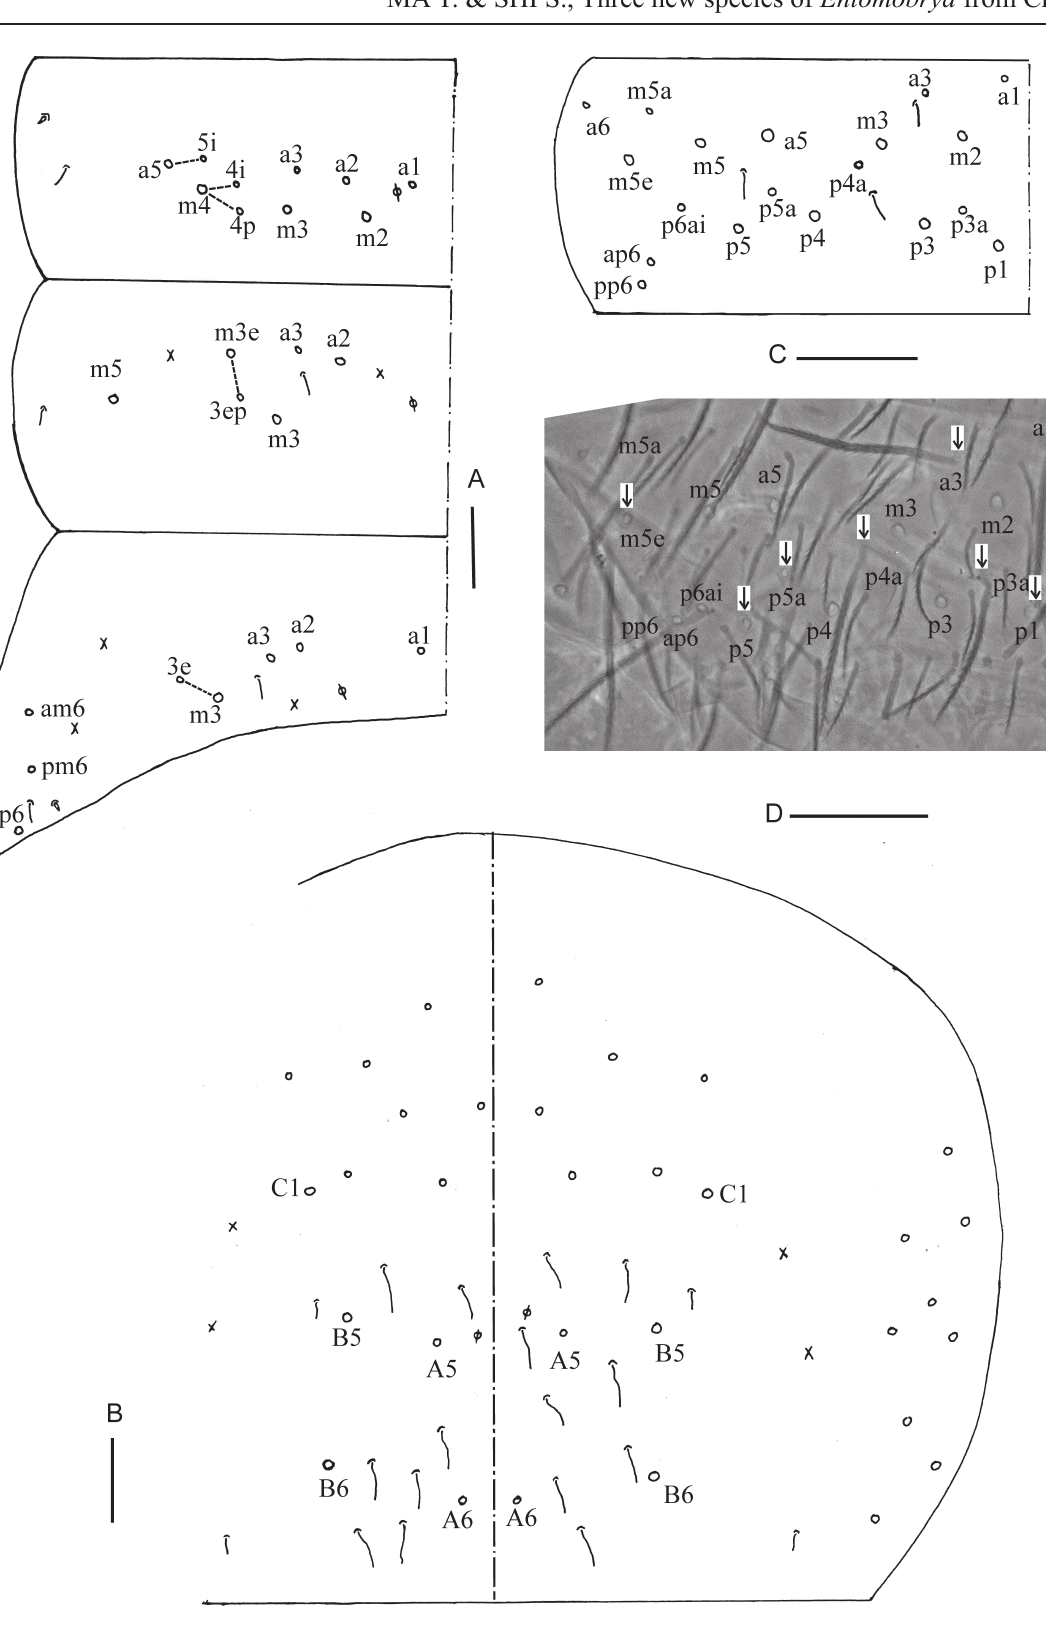
Fig. 14. Entomobrya dingi sp. nov. A . Chaetotaxy of Abd. I−III. B . Chaetotaxy of Abd. IV. C–D . Chaeto- taxy of Abd. V (arrows pointing to mac). Scale bars: A–D = 50